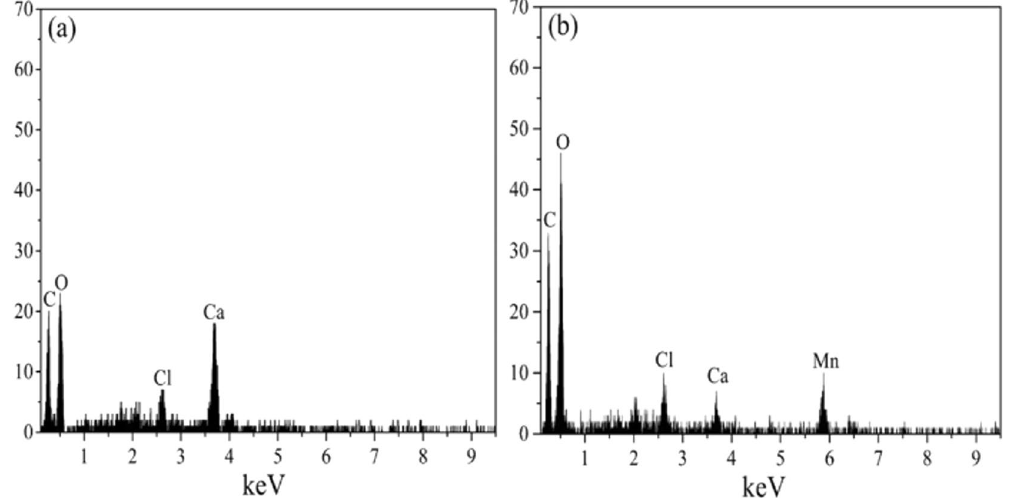
Figure 6. EDX of the GAD ( a ) before adsorption and the ( b ) after